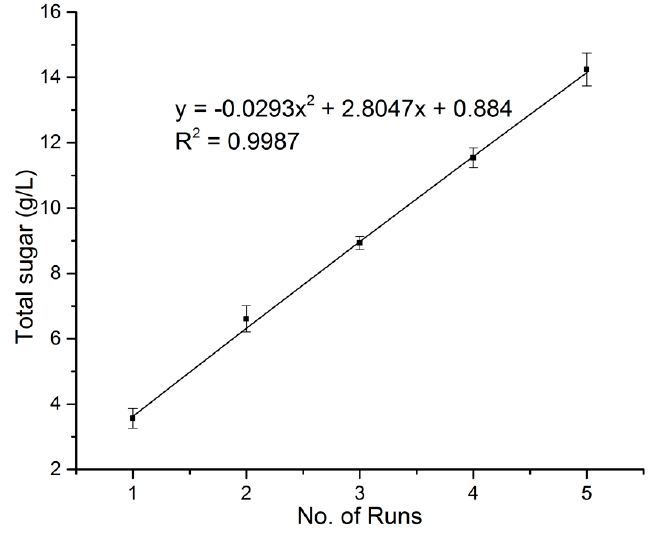
Figure 4. Effect of extraction times on sugar concentrations.